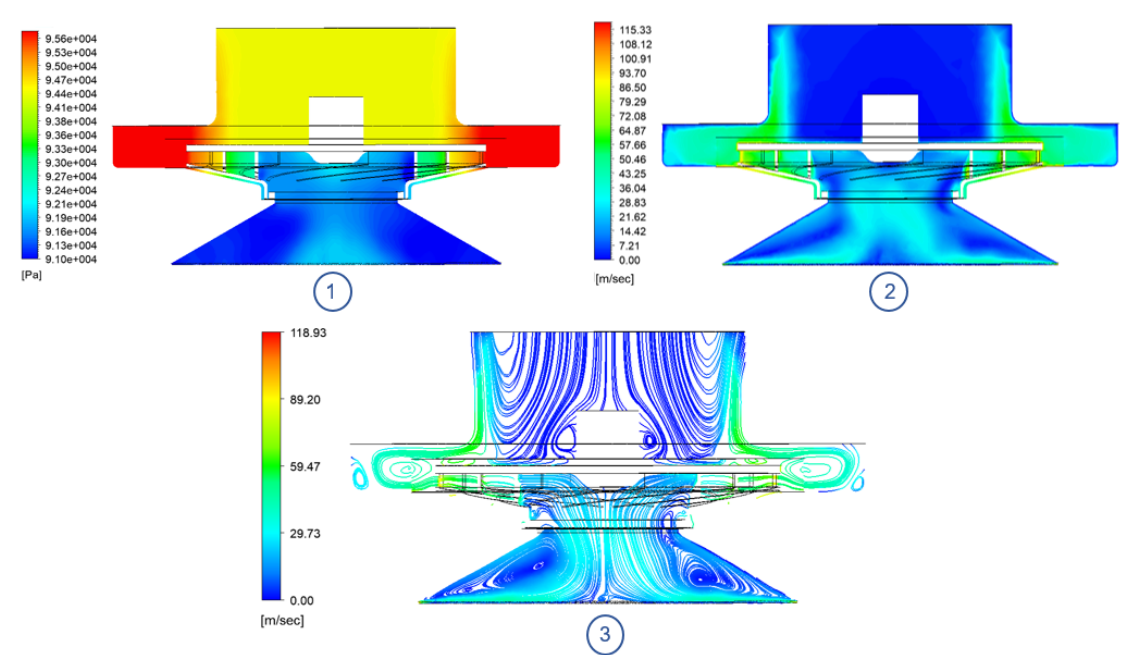
Figure 13. TBP model median plane @ 18,500 RPM: ( 1 ) Absolute pressure contour. ( 2 ) Velocity contour. ( 3 ) Streamlines.